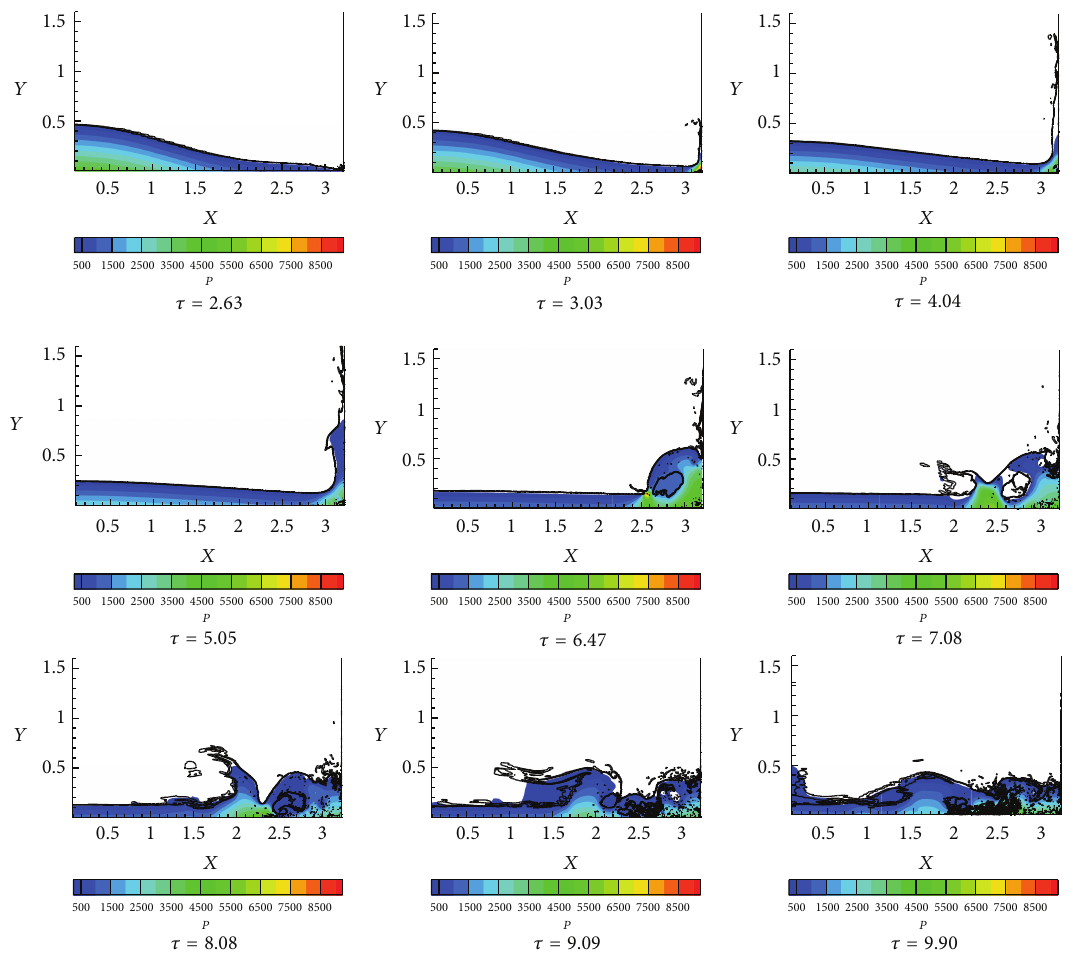
Figure 14: Pressure field and free surface of dam-break flow at different